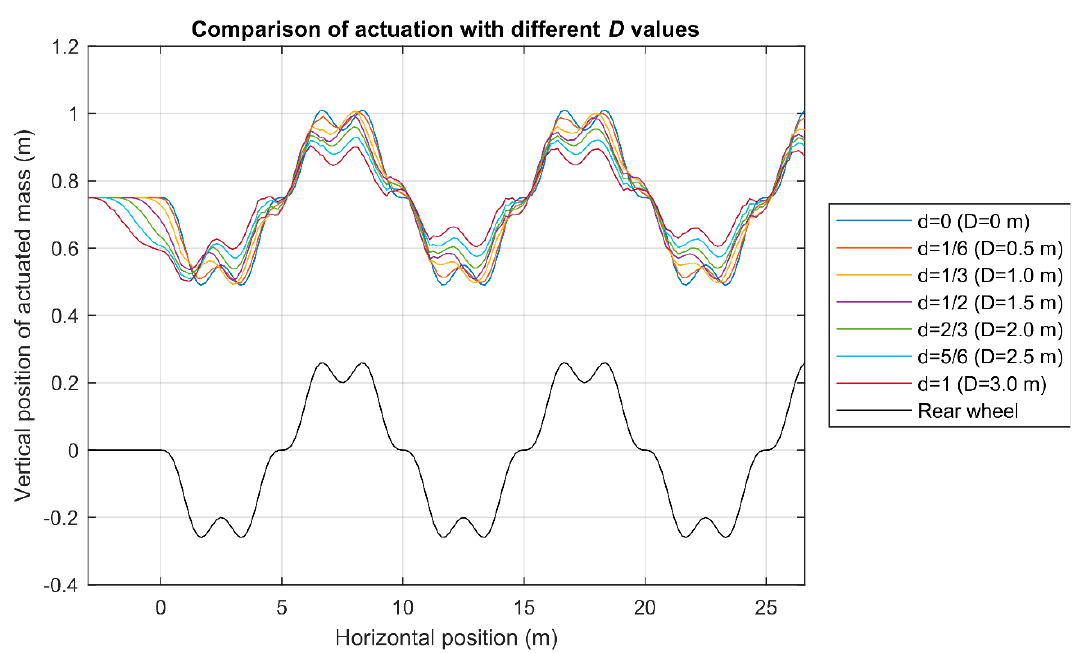
Figure 15. Displacement of the actuated mass in the second ground profile tested.